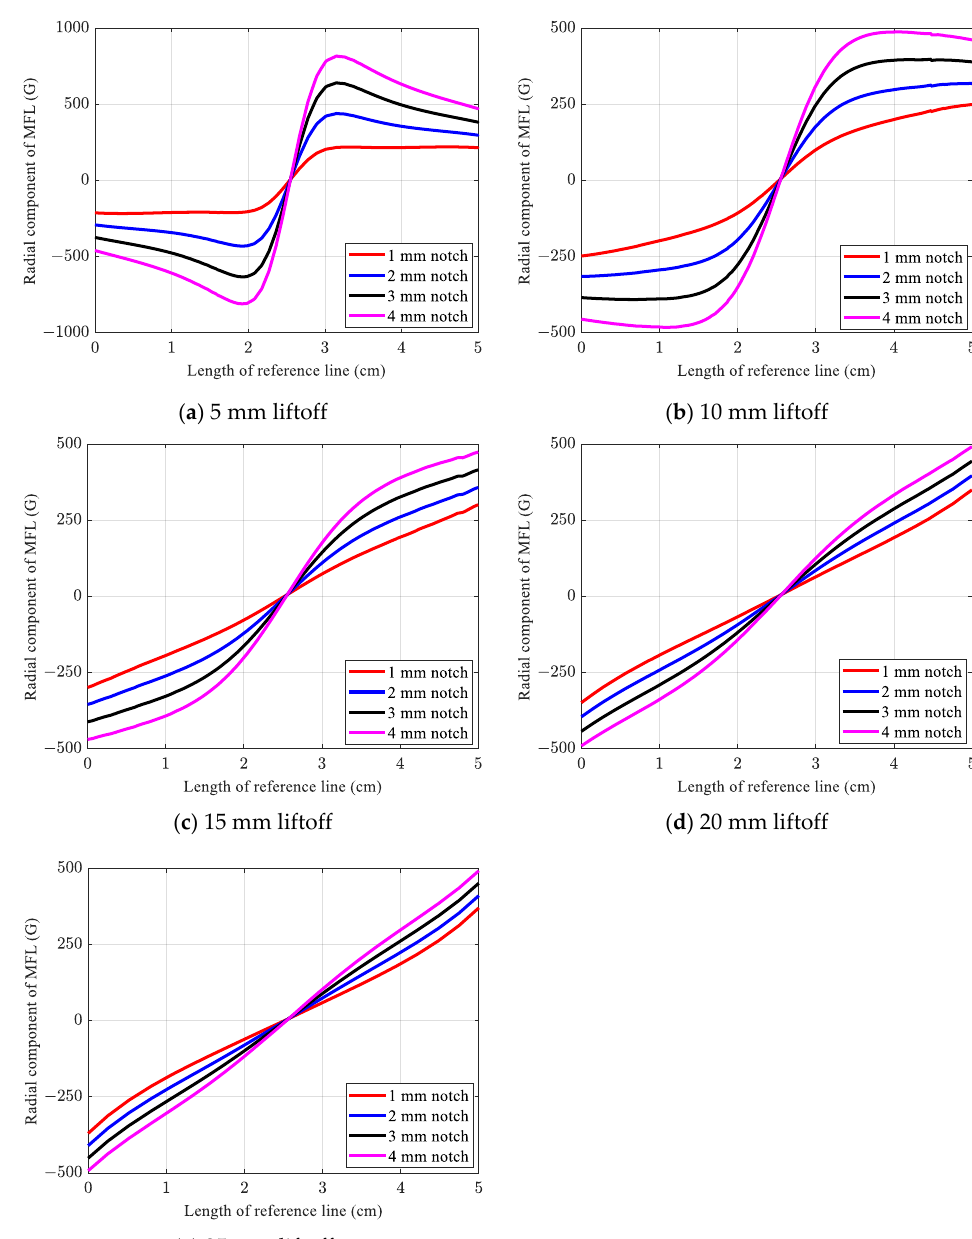
Figure 9. Effects of varying liftoff values on obtained MFL signal using the conventional method.